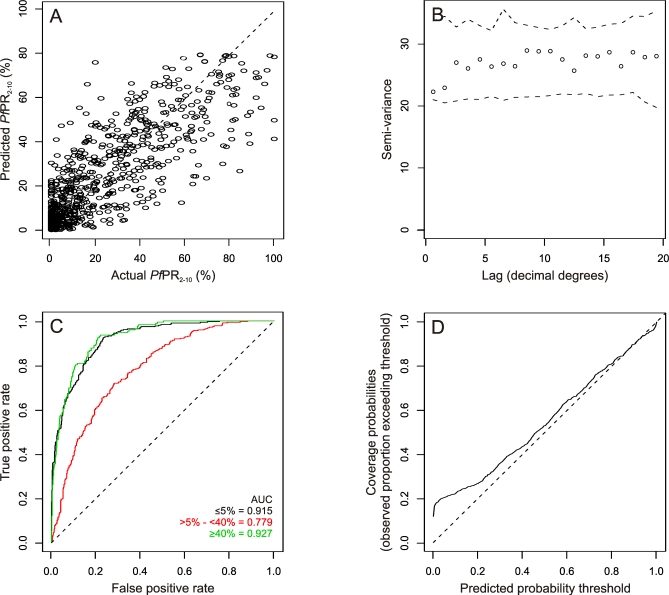
Model Validation Plots(A) Scatter plot of actual versus predicted point-values of PfPR2−10.(B) Sample semi-variogram of standardized model Pearson residuals estimated at discrete lags (circles) and compared to a Monte Carlo envelope (dashed lines) representing the range of values expected by chance in the absence of spatial autocorrelation.(C) Receiver-Operating-Characteristic curves for each PfPR2−10 endemicity class (black line, PfPR2−10 ≤ 5%; red line, PfPR2−10 > 5% to < 40%; green line, PfPR2−10 ≥ 40%) and associated AUC statistics.(D) Probability-probability plot comparing predicted probability thresholds with the actual percentage of true values exceeding those thresholds. In the top left and bottom left plots the 1:1 line is also shown (dashed line) for reference. See text for full explanation of validation procedures and interpretation of results.